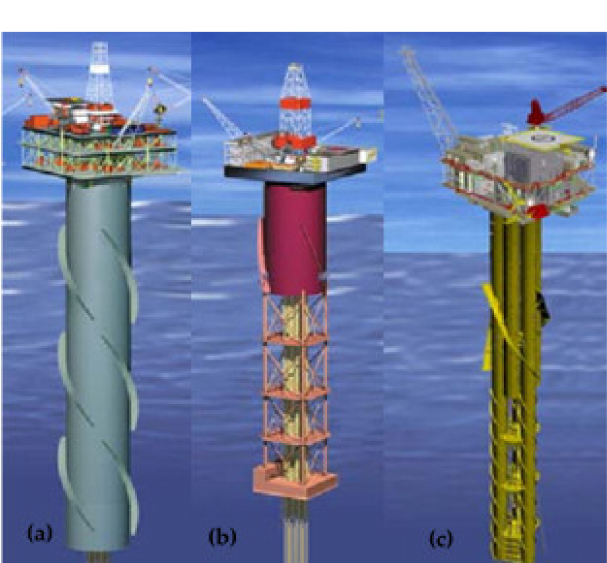
Figure 13. Types of Spar Platform: ( a ) Classic ( b ) Truss ( c )